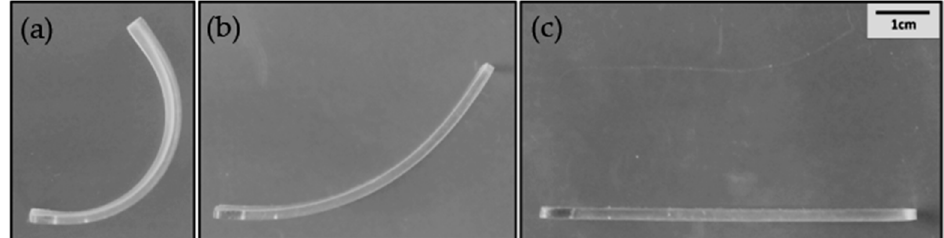
Figure 7. Typical EPOSS SMP in its U-like temporary shape ( a ), during deployment ( b ), and in its final permanent shape ( c ).